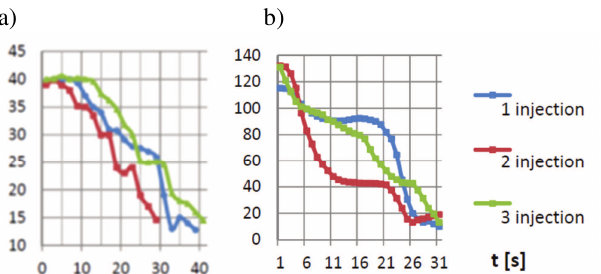
Fig. 8. Reaction time of the sorbent on SO 2 concentration, where: a) Ne = = 0.9 kW, b) Ne = 2.0